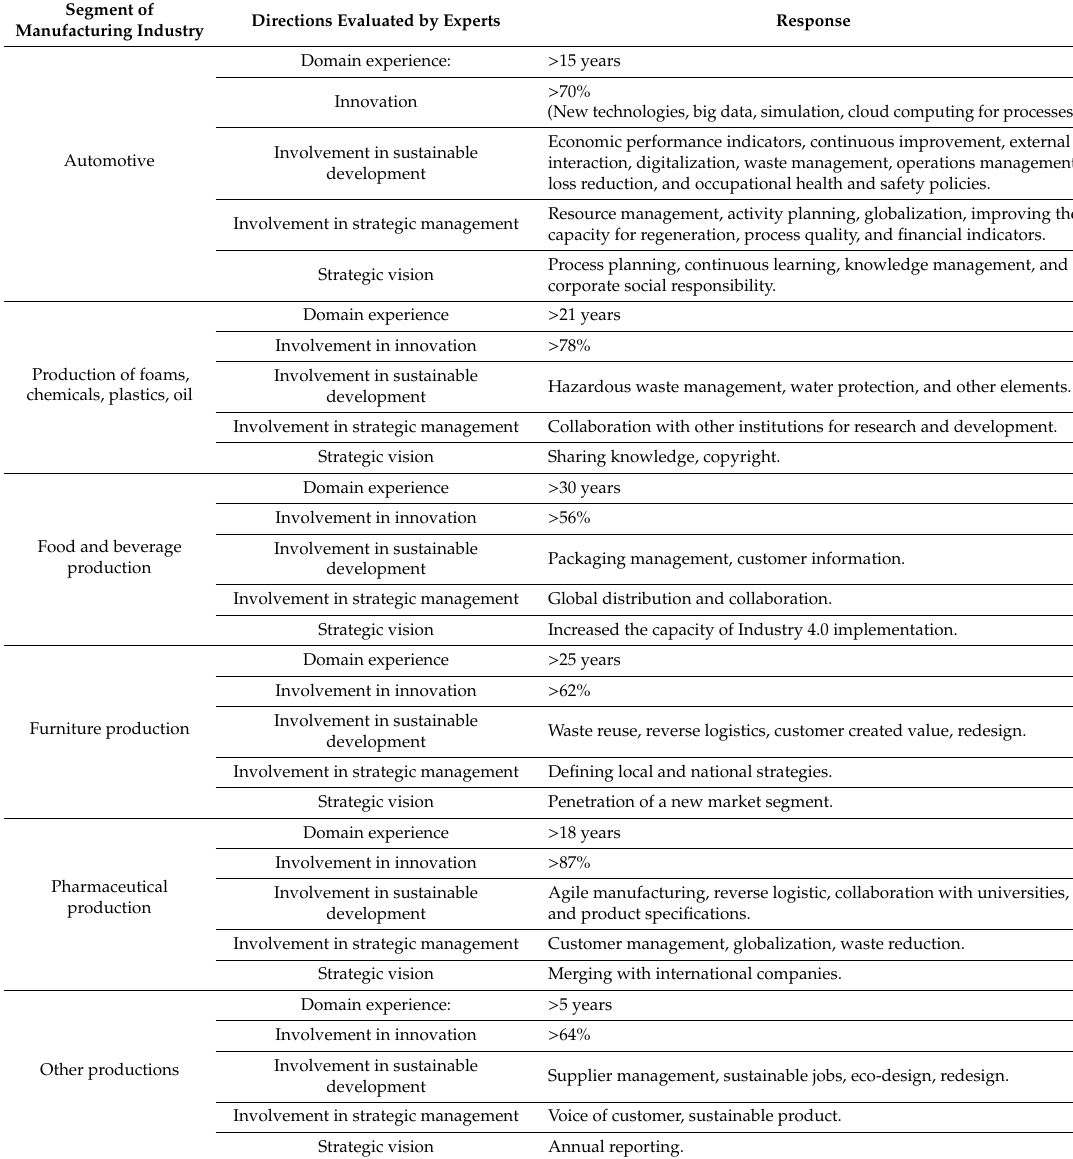
Table 6. Sustainable development and Industry